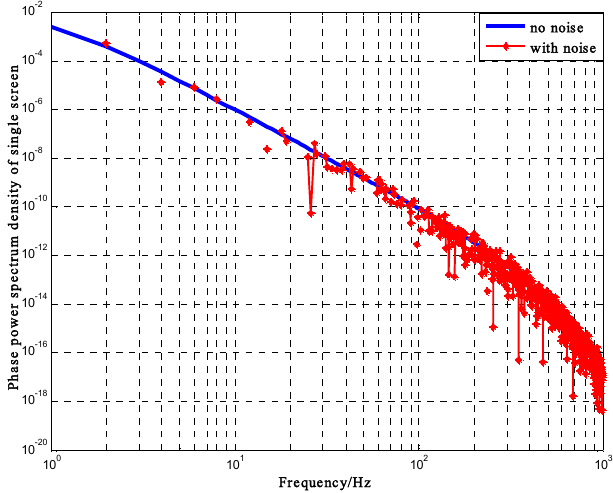
Figure 3. Phase PSD of single phase screen ( 2